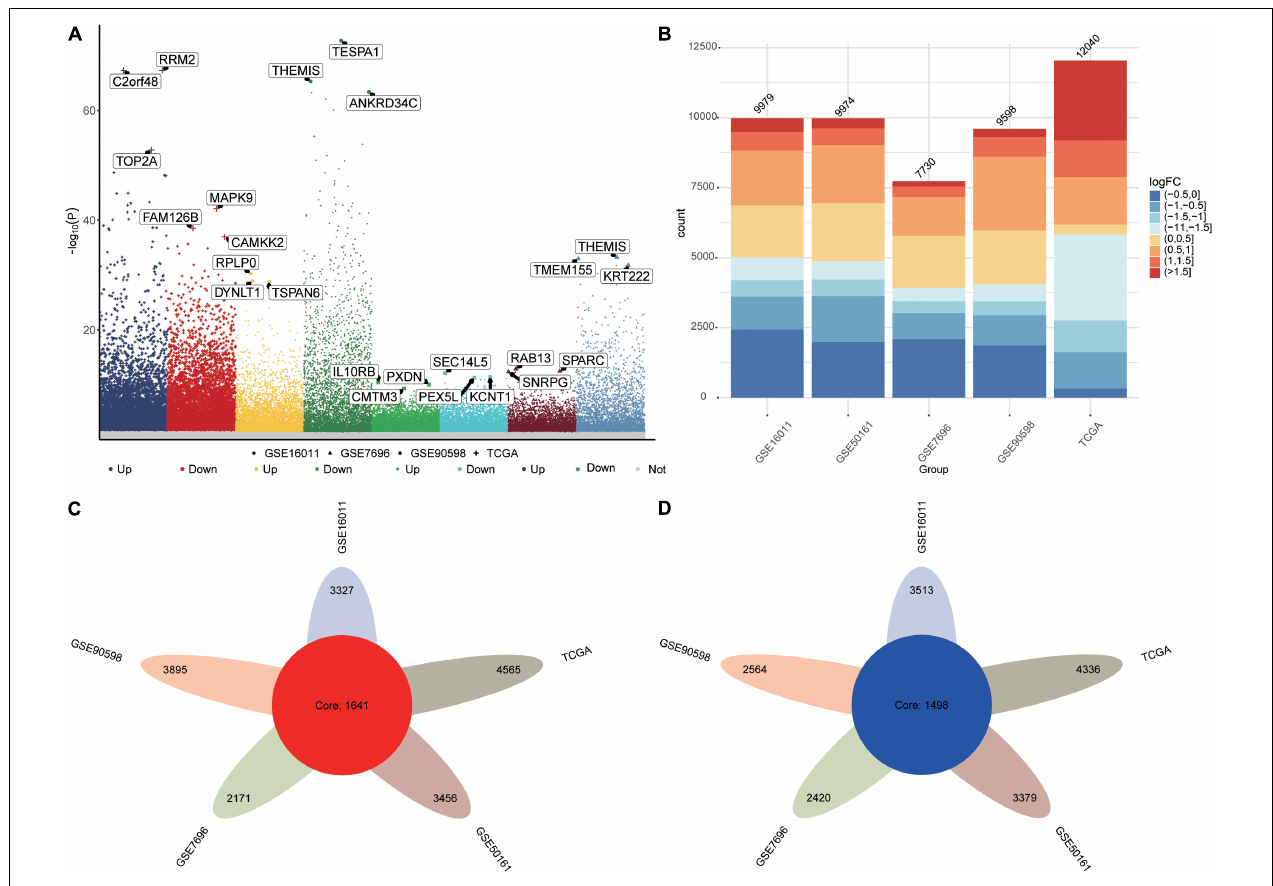
FIGURE 1 | Differentially expressed genes (DEGs) between GBM patients and controls. (A) Manhattan plot of DEGs in the datasets TCGA, GSE16011, GSE7696, GSE50161 and GSE90598. (B) Statistical bar graph of DEGs in each group. (C) DEGs upregulated in GBM across all five datasets. (D) DEGs downregulated in GBM across all five